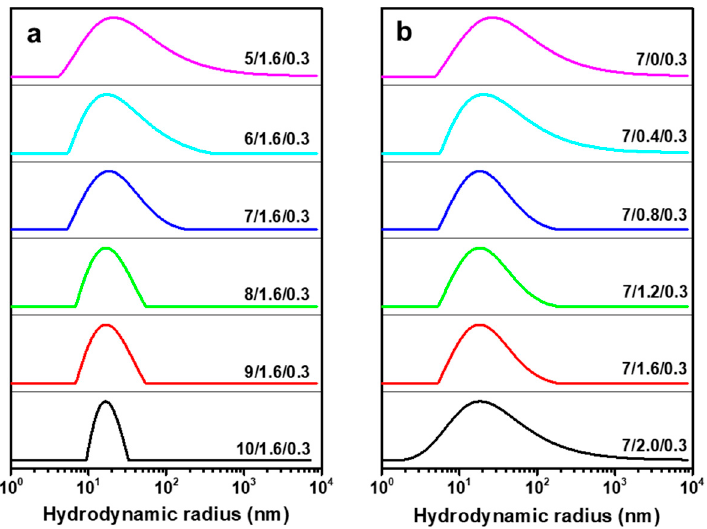
Figure 6. Hydrodynamic radius (R h ) distributions of CC (c = 0.3 g/L) in NaOH/ZnO aqueous solutions with various contents of ( a ) NaOH and ( b ) ZnO at 25 °C.